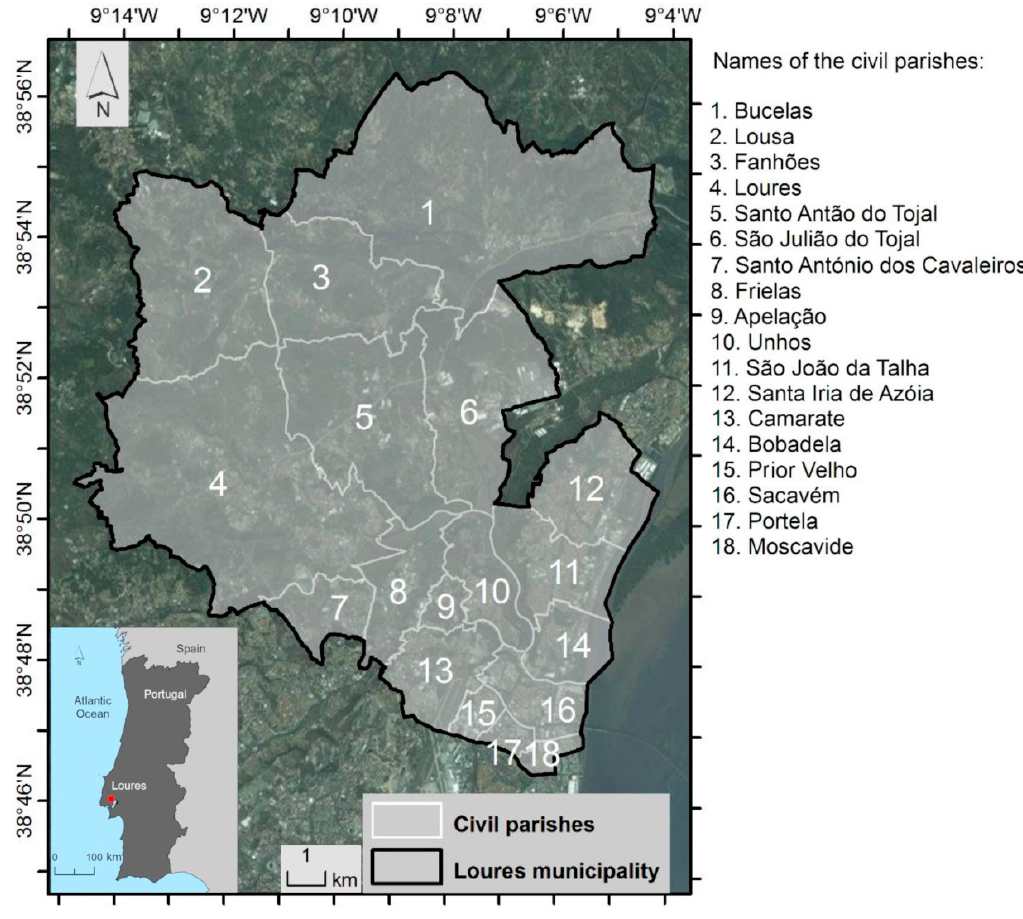
Figure 1. Civil parishes of the Loures municipality.